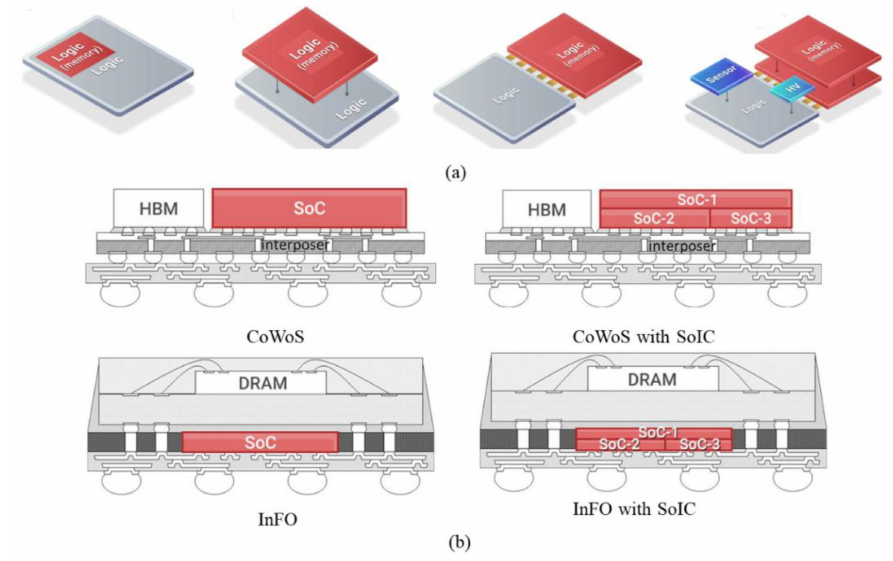
Figure 12. ( a ) Principle of SoIC Technology (reprinted from Ref. [58], Copyright 2019, with permission from IEEE); ( b ) compatible use of SoIC with CoWS and InFO (reprinted from Ref. [33], Copyright 2021, with permission from